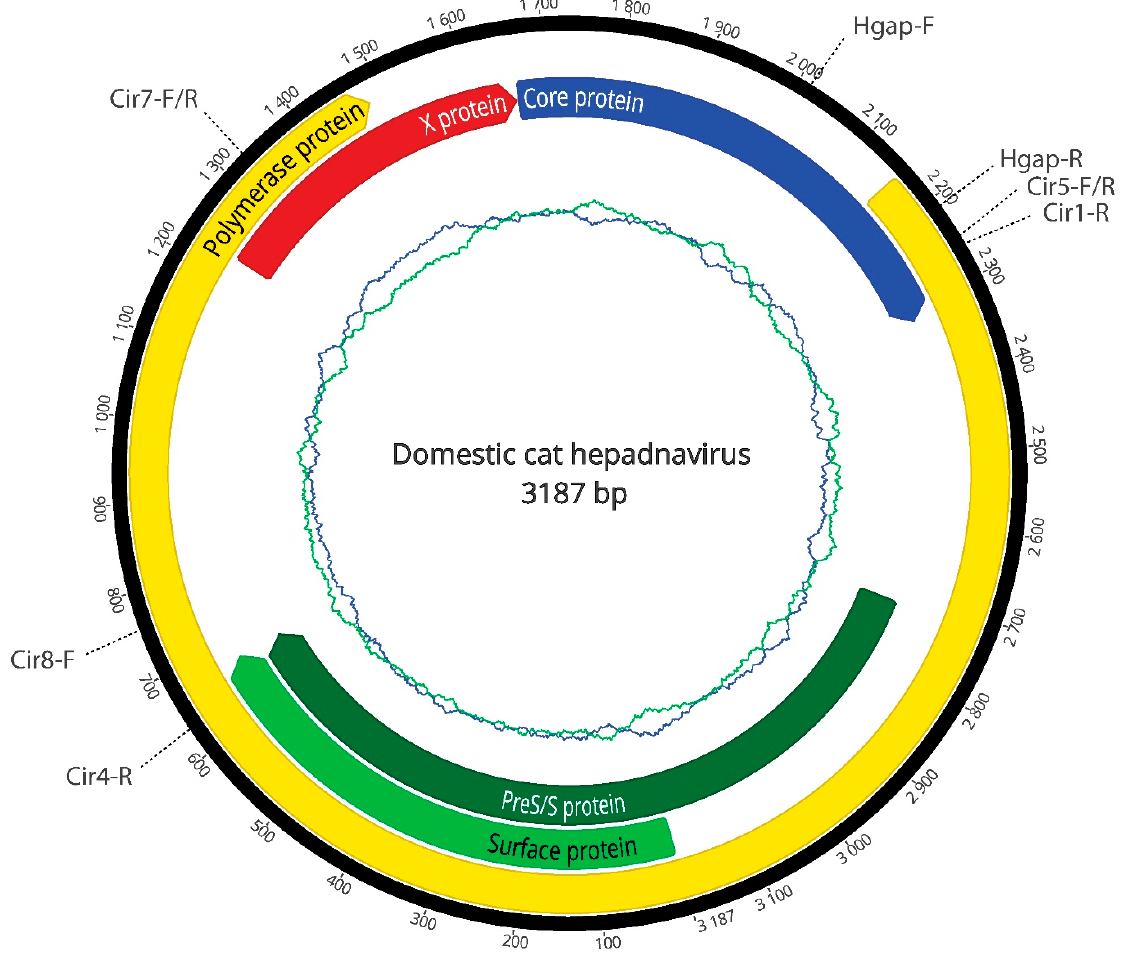
Figure 1. Genome organization of the domestic cat hepadnavirus. The complete genome consists of 3187 bp. The innermost circles represent the GC (blue) and AT (green) content of the genome. The proteins encoded by the polymerase, surface, core and X ORFs are labelled, as are the positions of primers used in this study (Table 1). Table 1. Oligonucleotides used to amplify the whole genome of domestic cat hepadnavirus.